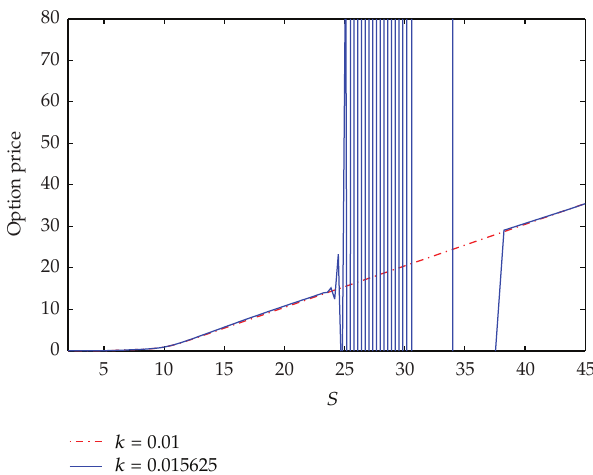
Figure 1: Satisfying and breaking stability